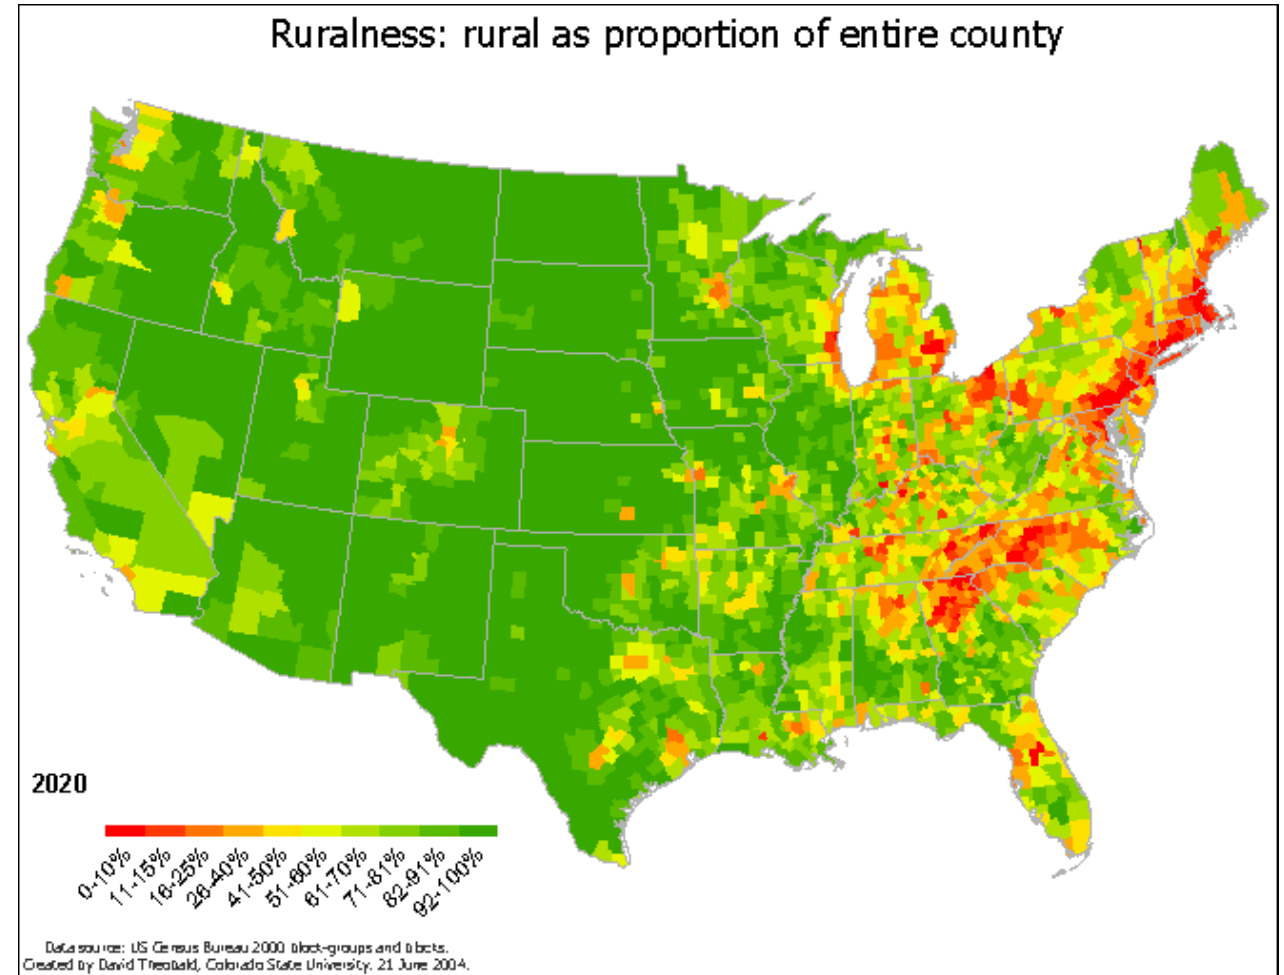
Fig. 14. Proportion of a county in rural housing density for